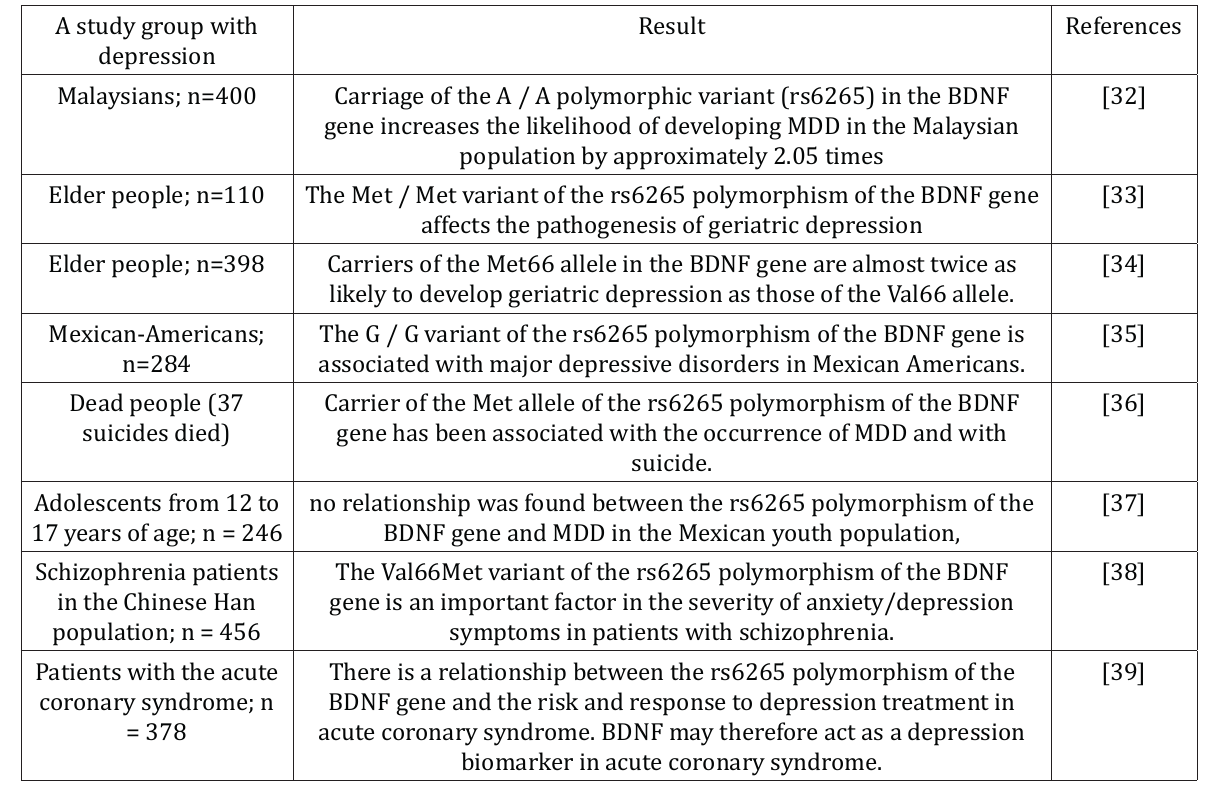
Table 1. The relationship of the rs6265 polymorphism of the BDNF gene and depression in different populations.